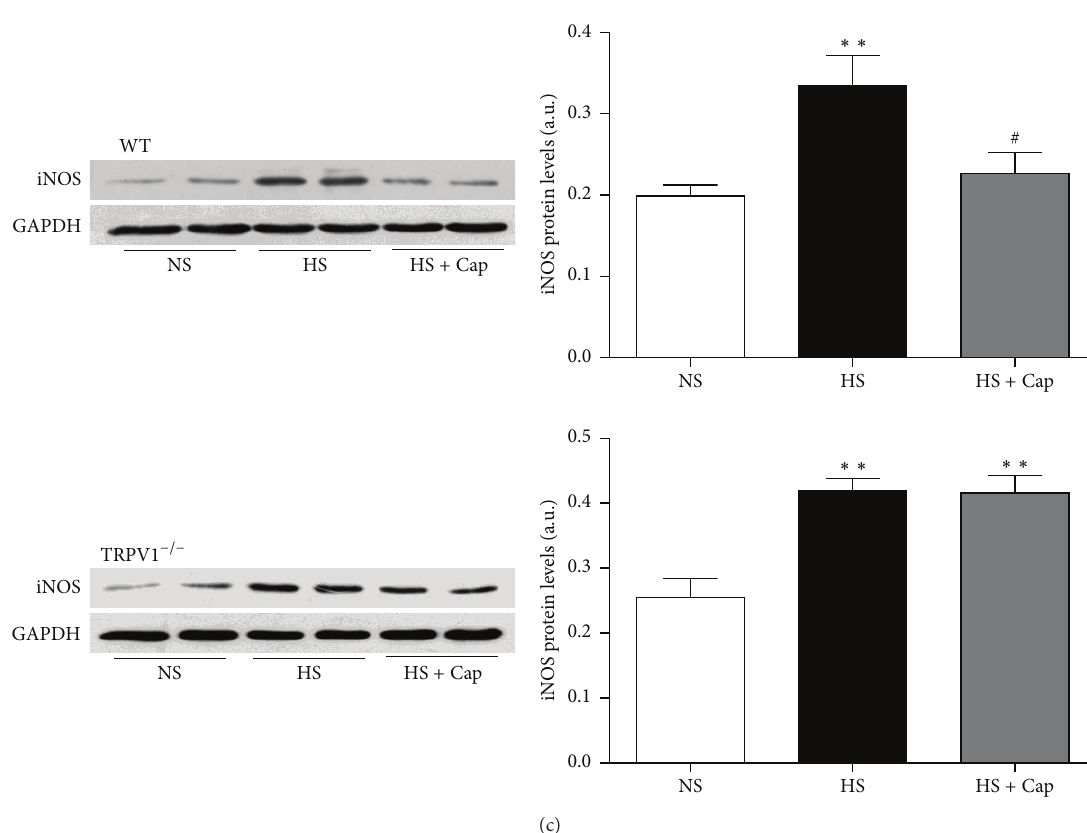
Figure 4: Dietary capsaicin upregulates PPAR- 𝛿 and UCP2 protein expression and decreases iNOS production in mice on long-term high- salt diet through TRPV1 activation. Immunoblottings of PPAR- 𝛿 (a), UCP2 (b), and iNOS (c) were performed in the left ventricular in WT and TRPV1 −/− from various groups. Data are means ± SEM from 3 separate experiments. ∗ 𝑃 < 0.05 , ∗∗ 𝑃 < 0.01 versus NS, # 𝑃 < 0.05 versus HS.